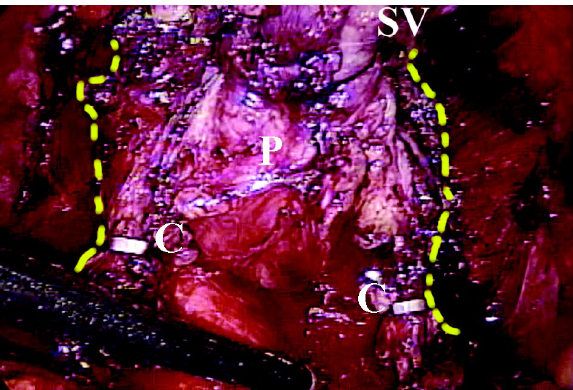
Figure 10 – The prostatic pedicles are identified and clipped. P = prostate. C = polymer clip. Observe the path of the nervi erigentes (dotted lines). SV = seminal